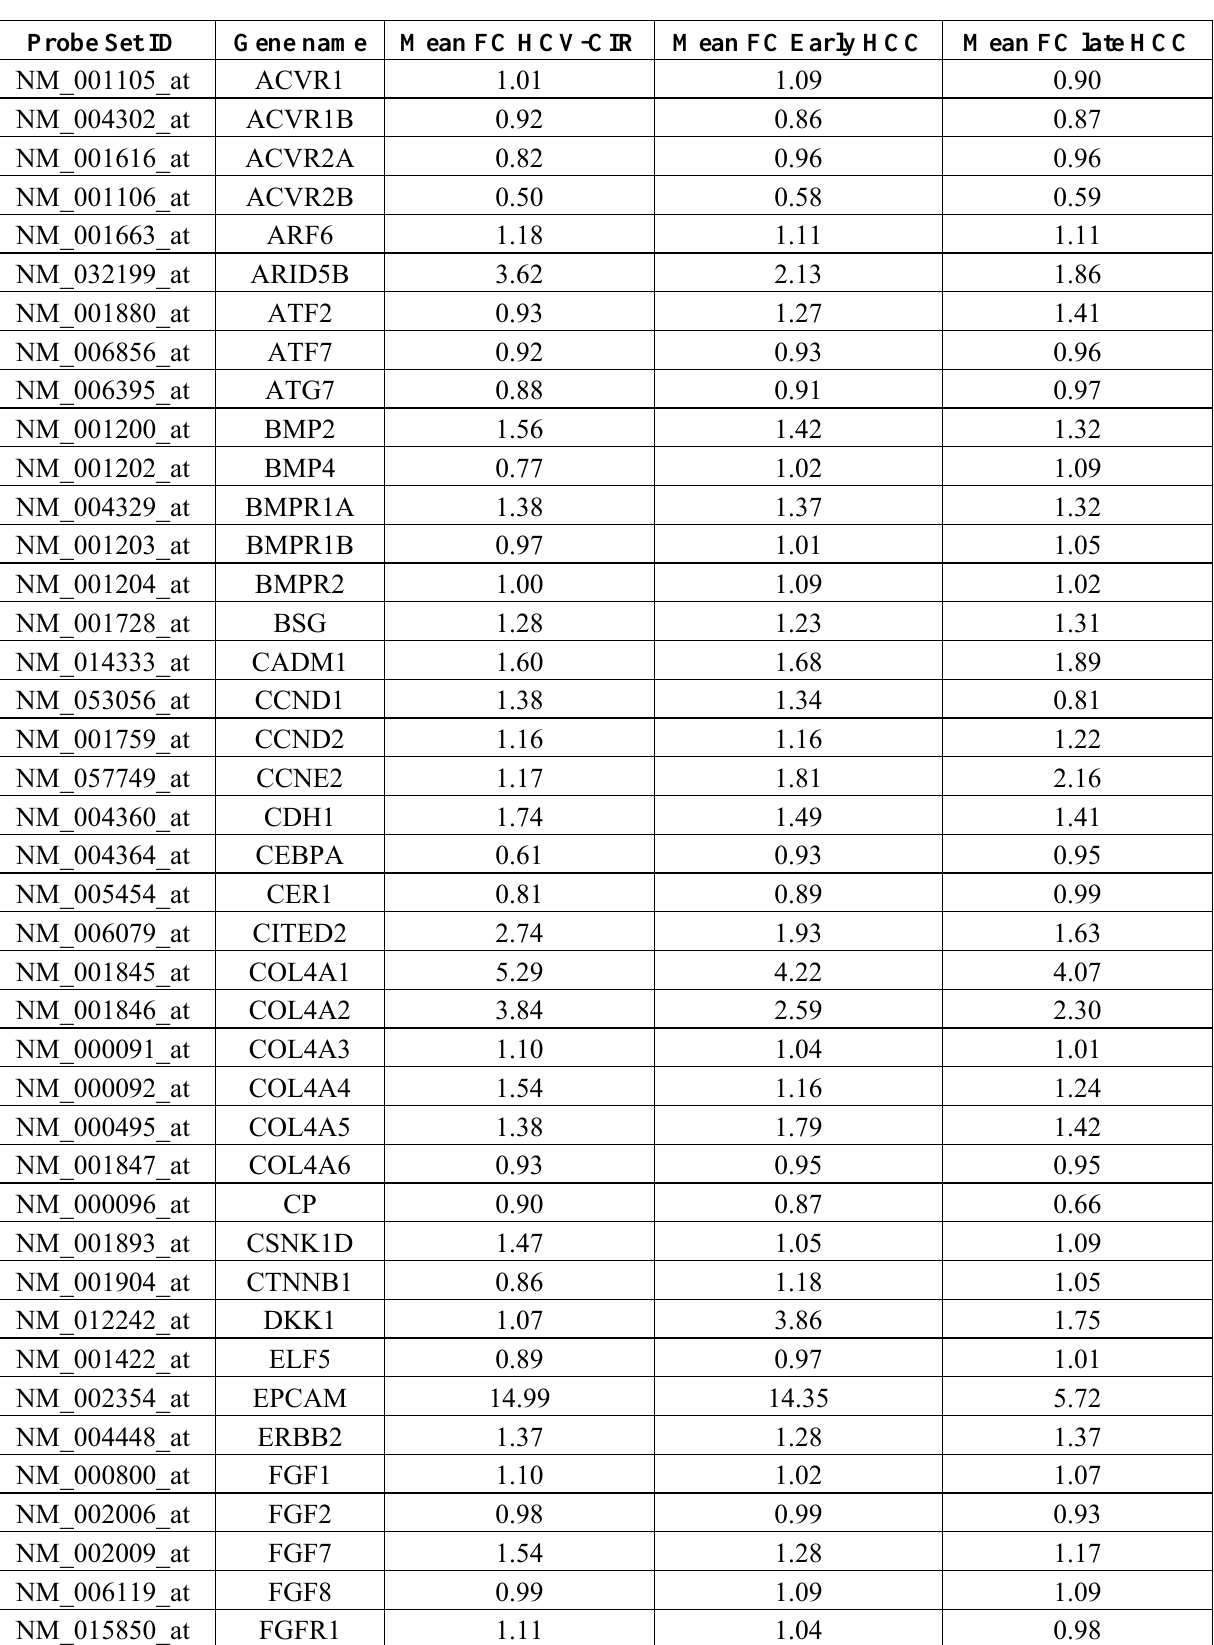
Table S2. All liver development genes tested and their relative expression in HCV-cirrhosis, HCC-cirrhotic tissues, early stage HCC and late stage HCC. Fold-change (FC) is relative to normal